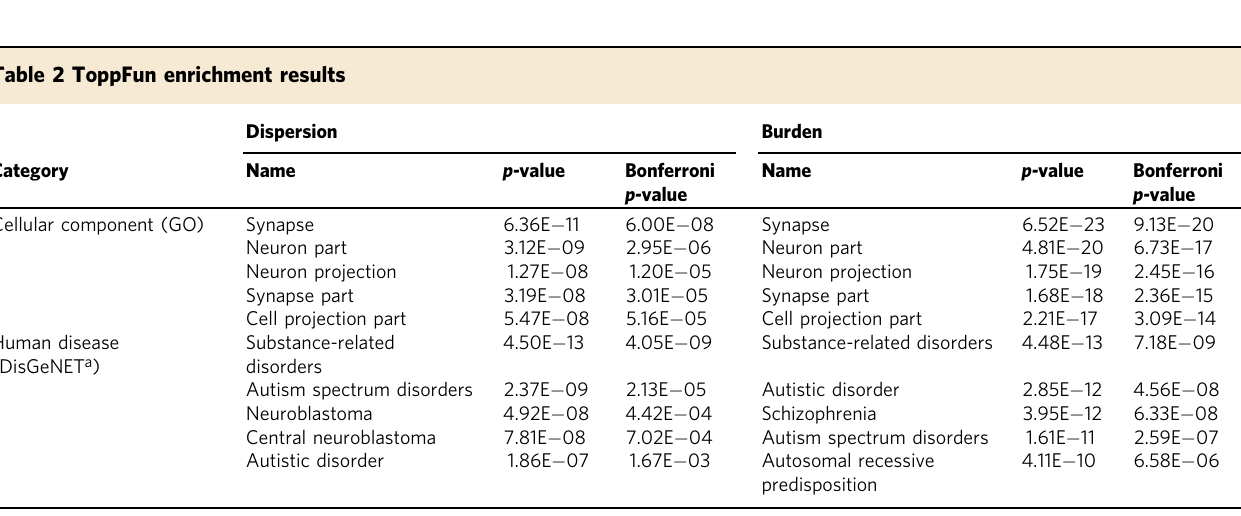
Table 2 ToppFun enrichment